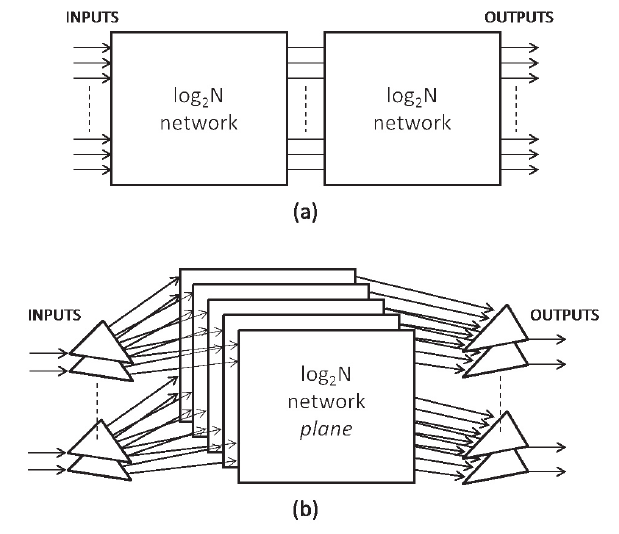
N networks: with horizontal cascading ( a ) and vertical 2